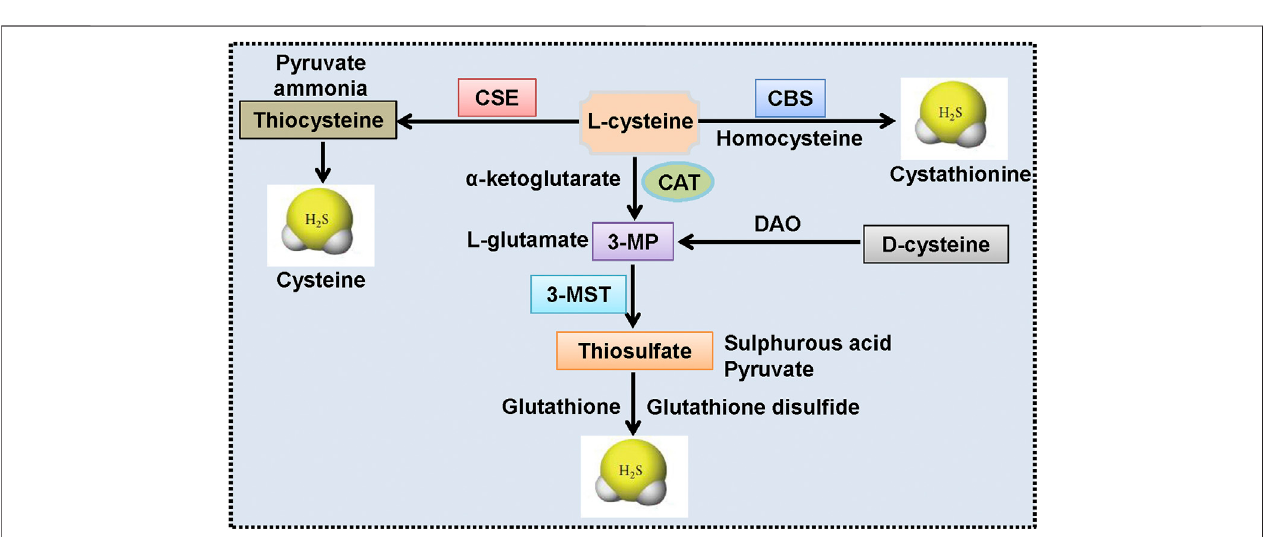
FIGURE 2 | Endogenous synthesis pathways of H2S. CSE produces H 2 S by using L -cysteine as the main substrate, accompanied by the generation of ammonia, pyruvate,andthiocysteine.ThelatterwouldbecatalyzedintoH 2 Sandcysteine.CBS-mediatedH 2 Sproductionisdependentonthetransformationofhomocysteineand L -cysteine to H 2 S and cystathionine. CAT catalyzes the conversion of L -cysteine and α -ketoglutarate to 3-MP and L -glutamate, and 3-MP is then catalyzed to sulfurous acid, pyruvate and thiosulfate by 3-MST. Thiosulfate is then reduced to H 2 S and glutathione disul fi de by using reduced glutathione. Moreover, D -cysteine could be